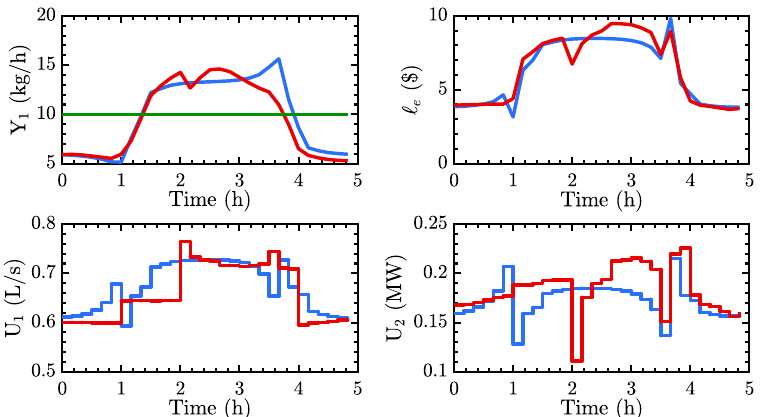
Figure 11. CO 2 emission, input and economic cost trajectories of the PCC plant for scenario 2 with carbon tax set at $50.00 per tonne CO 2 . EMPC (blue), MPC (red), Emission limit (green); ( top-left ) mass flow rate of CO 2 in the treated flue gas; ( top-right ) economic performance of controller; ( bottom-left ) volumetric flow rate of solvent; ( bottom-right ) heat input to